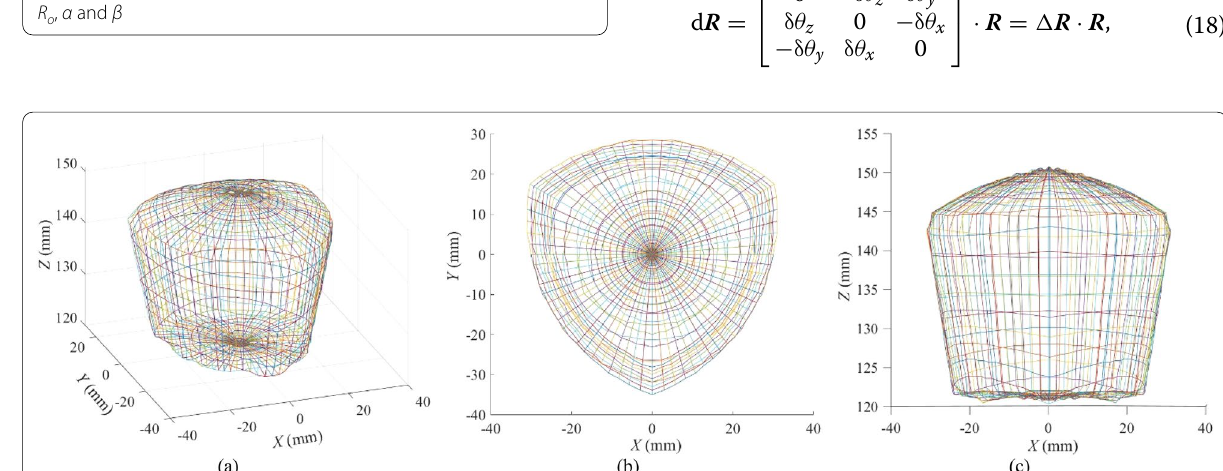
Figure 15 Workspace of the PM: a 3D view of the workspace, b Workspace in XY plane, c Workspace in XZ